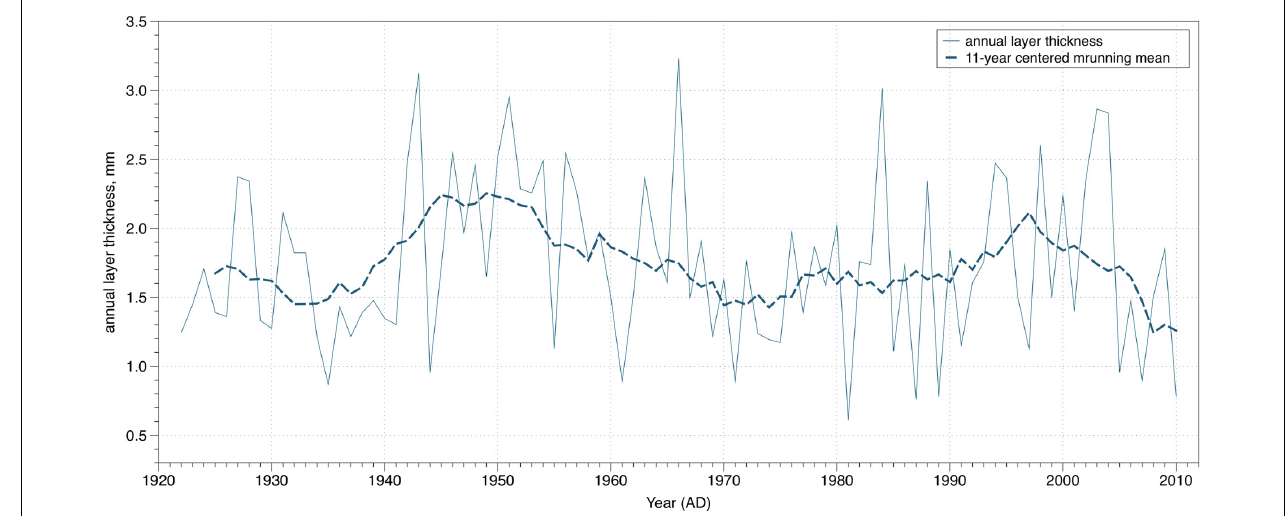
FIGURE 12 | Rb/Sr-derived annual layer thickness and its centered 11-year running